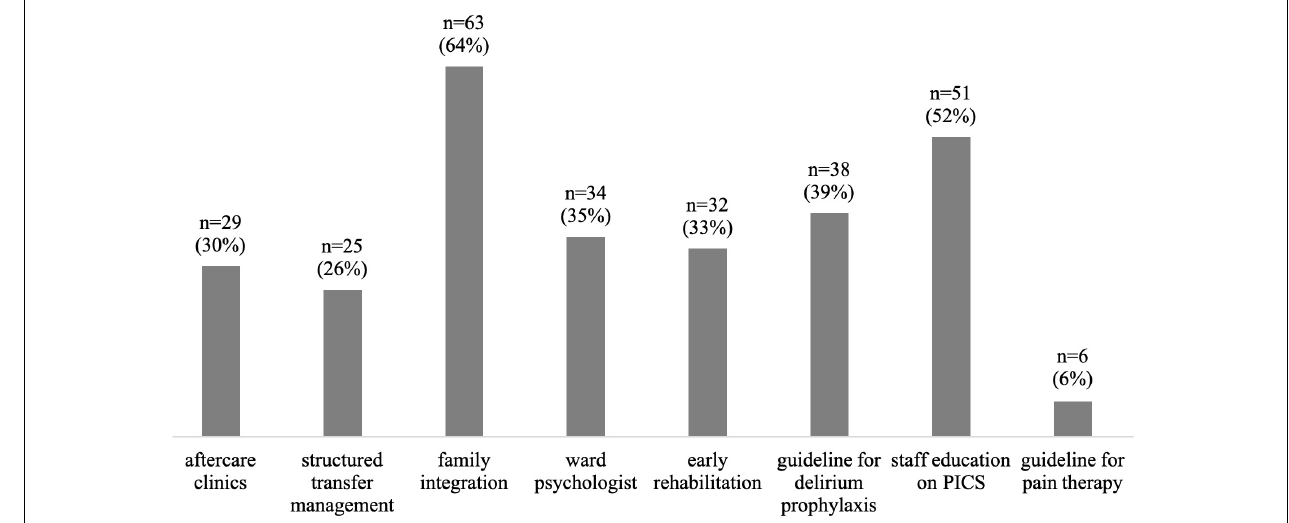
FIGURE 2 | Suitable measures (in terms of effort/benefit) to prevent PICS; n = 98 (multiple choice).